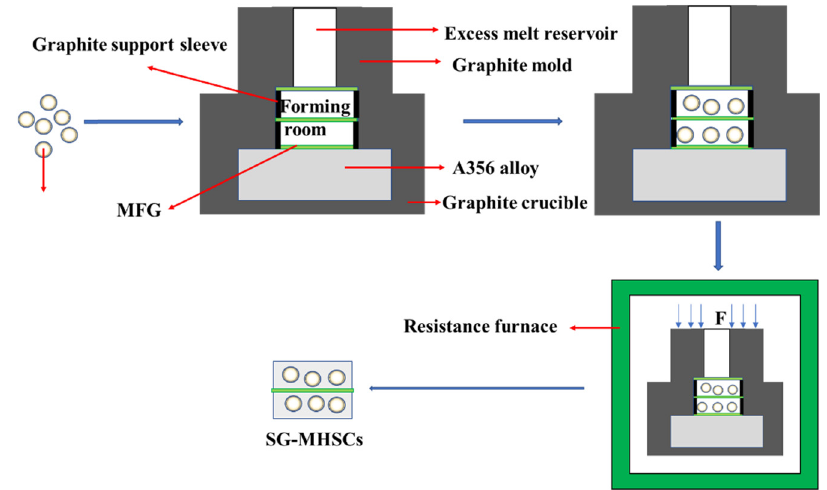
Figure 1: The schematic of fabricating SG - MHSCs.